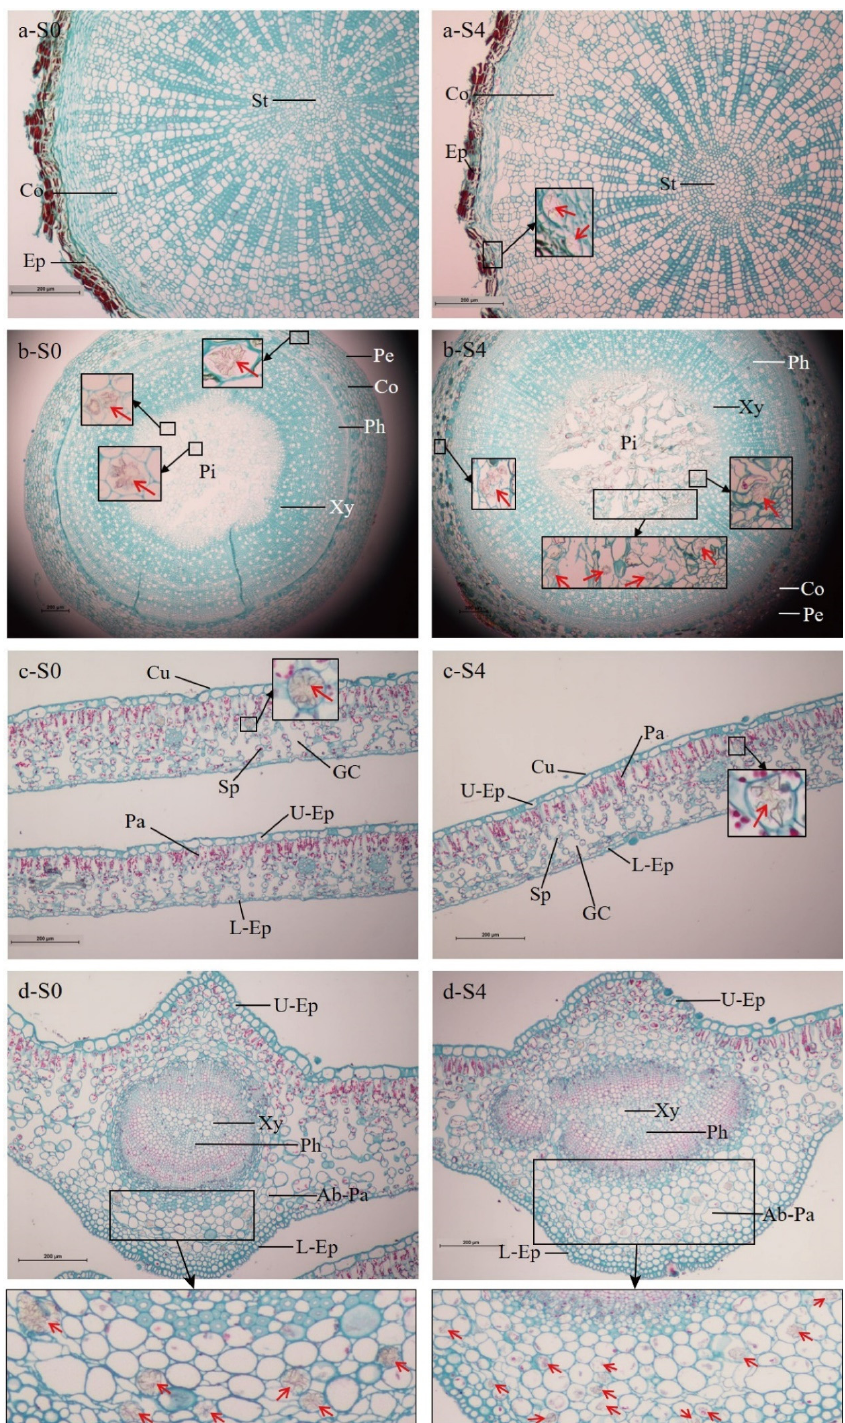
Figure 6. Effects of salinity stress on the anatomical structure of the ( a ) root, ( b ) stem, ( c ) mesophyll, and ( d ) main vein in C. elegans seedlings. To highlight the contrast effects, only images from the S0 (control treatment) and S4 (0.4% salt concentration treatment) are shown here. Ep, epidermis; Co, cortex; St, stele; Pe, periderm; Ph, phloem; Xy, xylem; Pi, pith; Cu, cuticula; U-Ep, upper epidermis; Pa, palisade tissue; Sp, spongy tissue; L-Ep, lower epidermis; GC, gas chamber; Ab-Pa, abaxial parenchyma. The red arrows indicate the regions of calcium oxalate crystals deposition in various tissues. The black box area shows the magnified picture. Bar = 200 µ